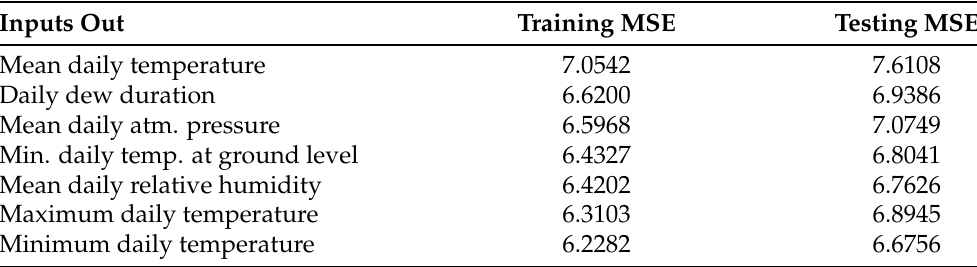
Table 8. The results of the sensitivity analysis for the prediction of the maximum daily